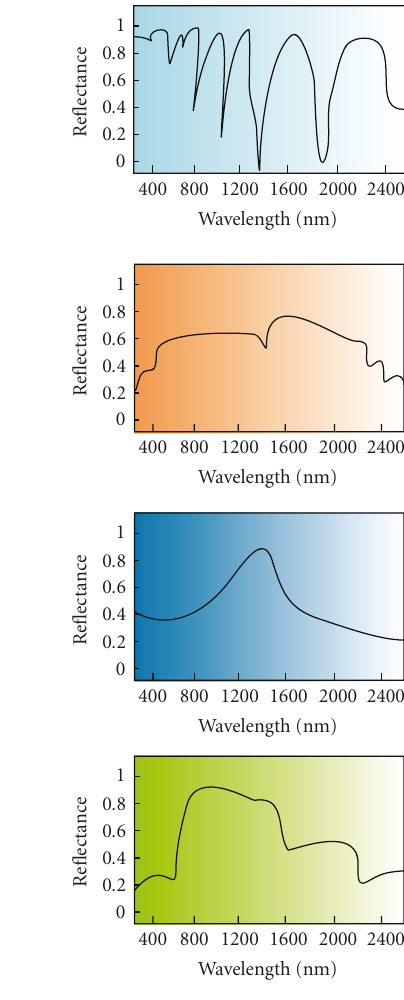
Figure 1: The concept of hyperspectral